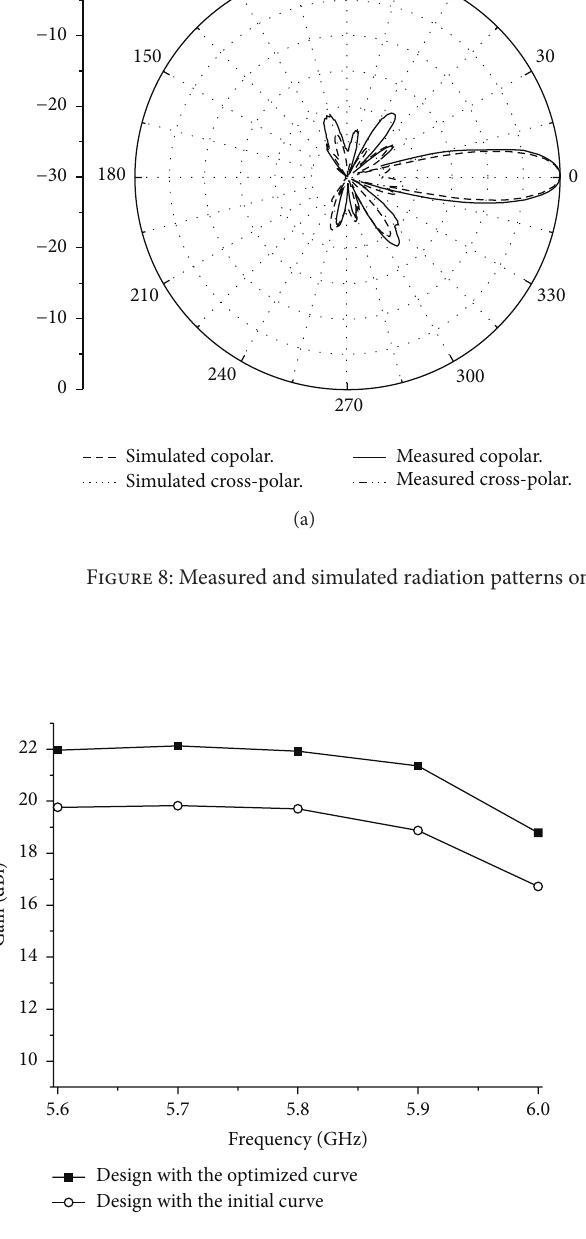
Figure 9: Gain comparison with frequency varying from 5.6 to 6.0